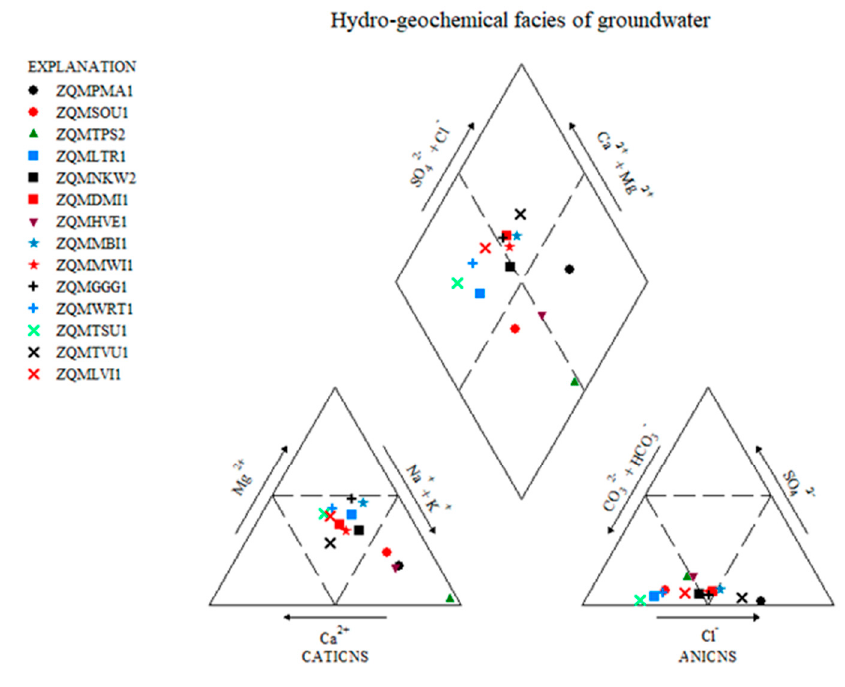
Figure 7. Spatial distribution of magnesium in the Soutpansberg region.